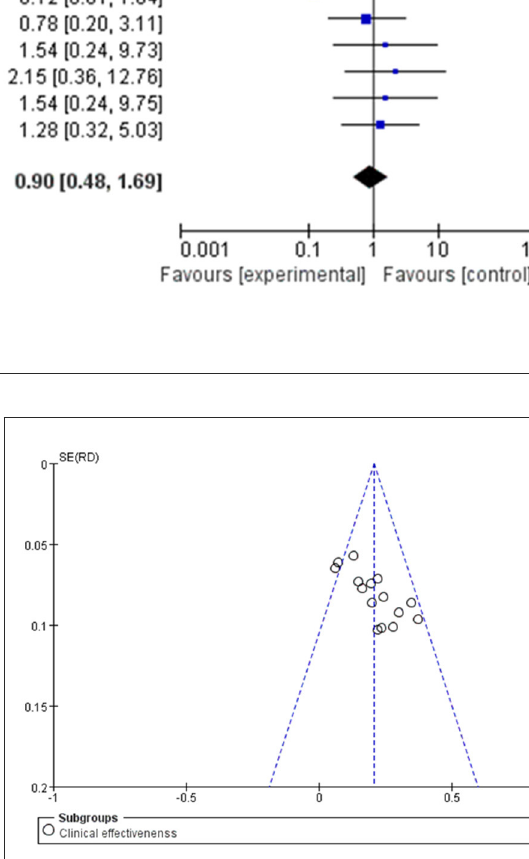
FIGURE10 Funnel plot of the total efficacy of Shenkang injection combined with alprostadil and control